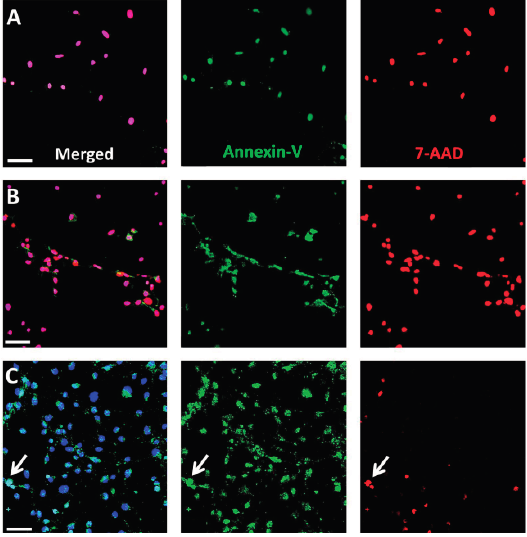
Figure 6. Staining for 7-AAD (red) and Annexin-V (green) was performed on NaIO 3